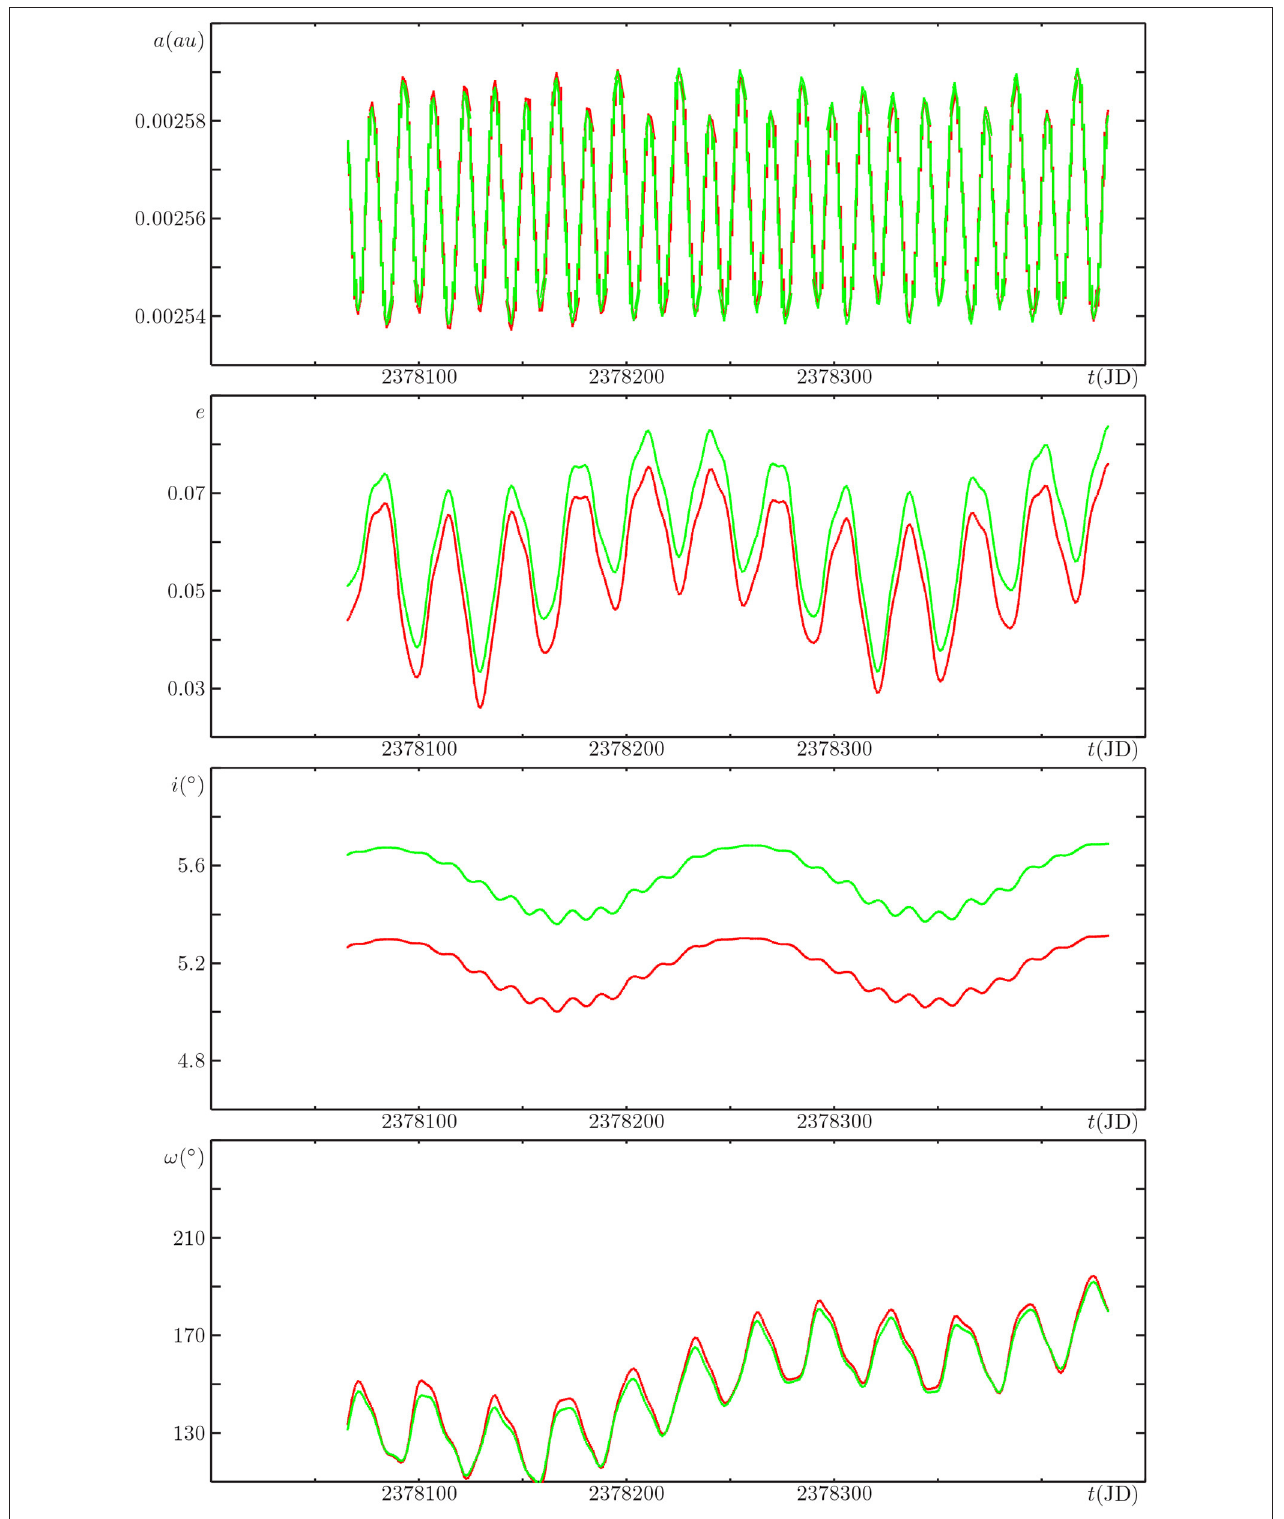
FIGURE 2 | Same as Figure 1 , but for the time span of one year, ending one Saros later, on 28.693 October 1799.